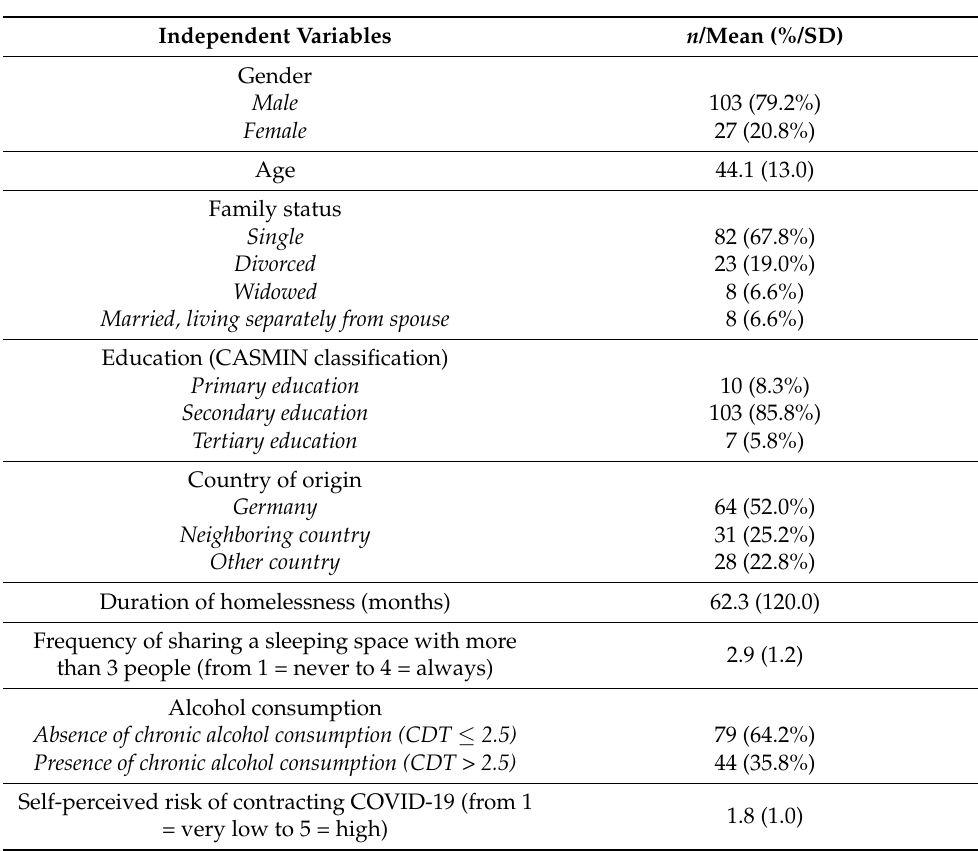
Table 1. Sample characteristics ( n =